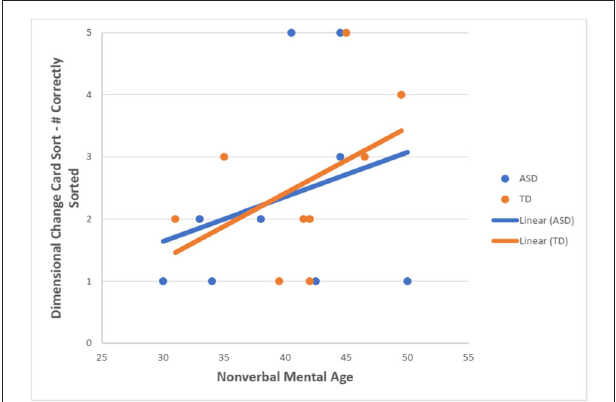
FIGURE 6 | Scatterplot showing the relationship between NVMA and a number of correctly sorted post-switch DCCS trials for both groups matched on